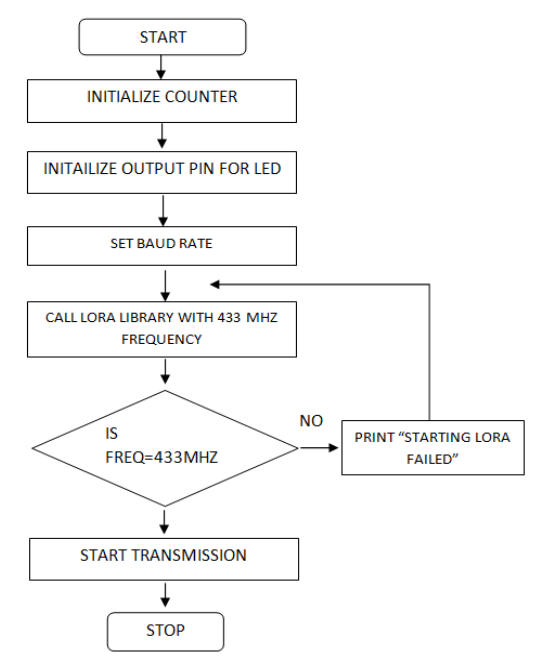
Fig. 4. Steps for LoRa transmission